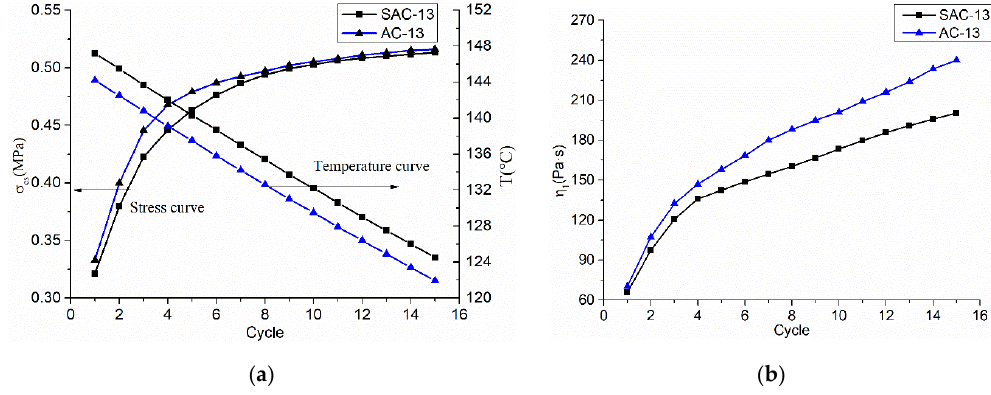
Figure 10. Model parameters and temperature curves with load cycle times; ( a ) σ es and T curves with load cycle times; and, ( b ) η 1 curves with the load cycle times.